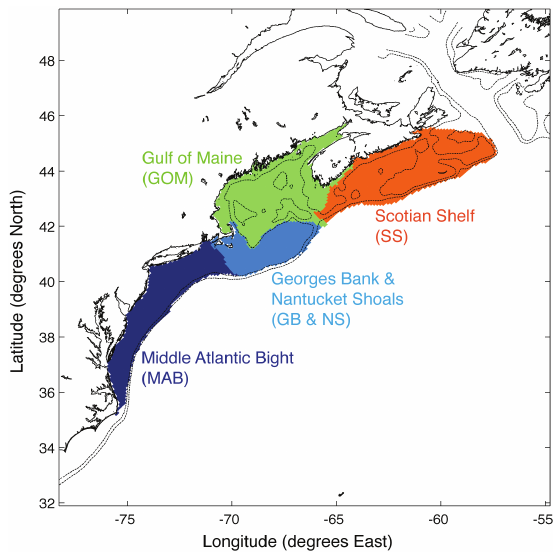
Fig.2. Geographicshelfregionsusedforbudgets. Thedashedlines showthe100mand200misobaths. Fig. 2. Geographic shelf regions used for budgets. The dashed lines show the 100m and 200m